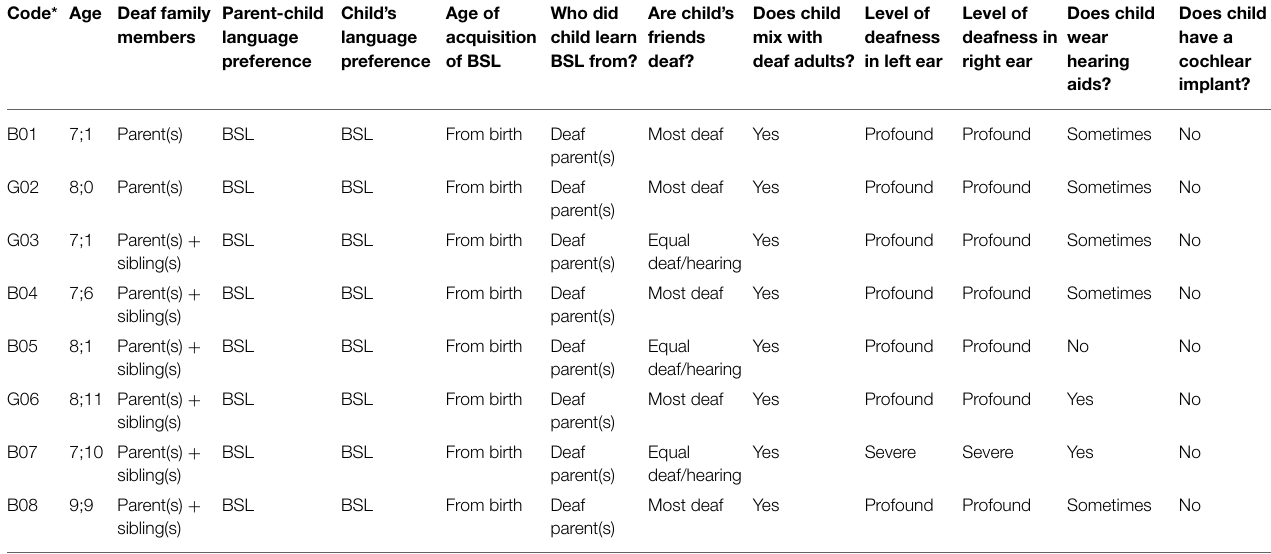
TABLE 1 | Language background of deaf native